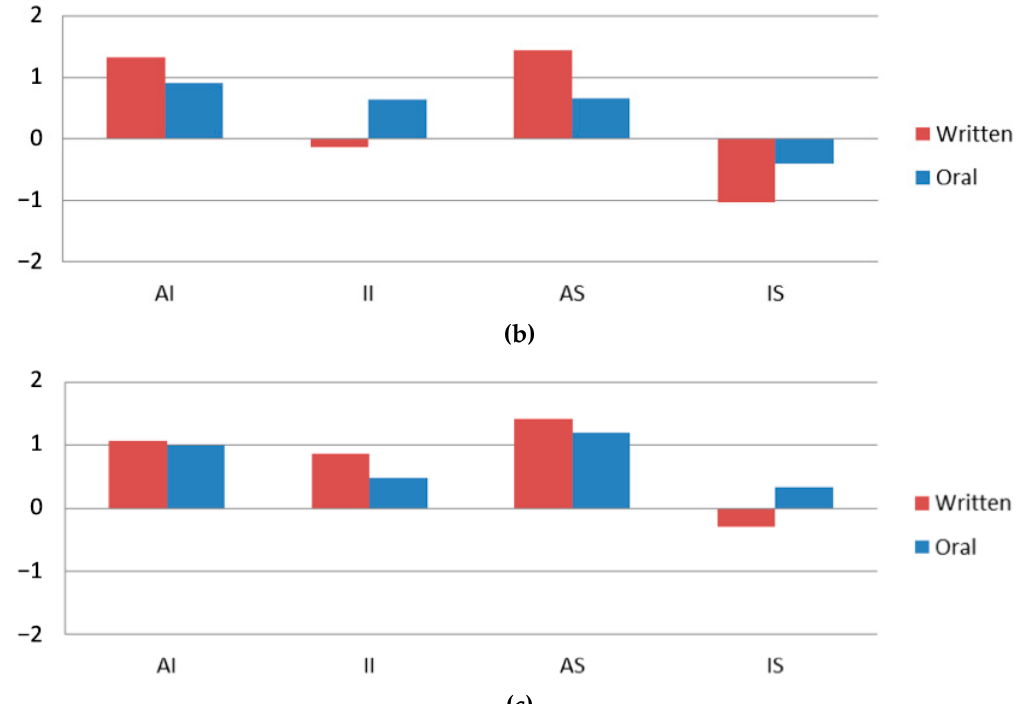
Figure 3. Task 1 vs. Task 3—Sentence combination felicity task (written vs. oral), results by group. (a) Task 1 vs. Task 3 (L1SP); (b) Task 1 vs. Task 3 (L2SP); (c) Task 1 vs. Task 3 (HLSP).